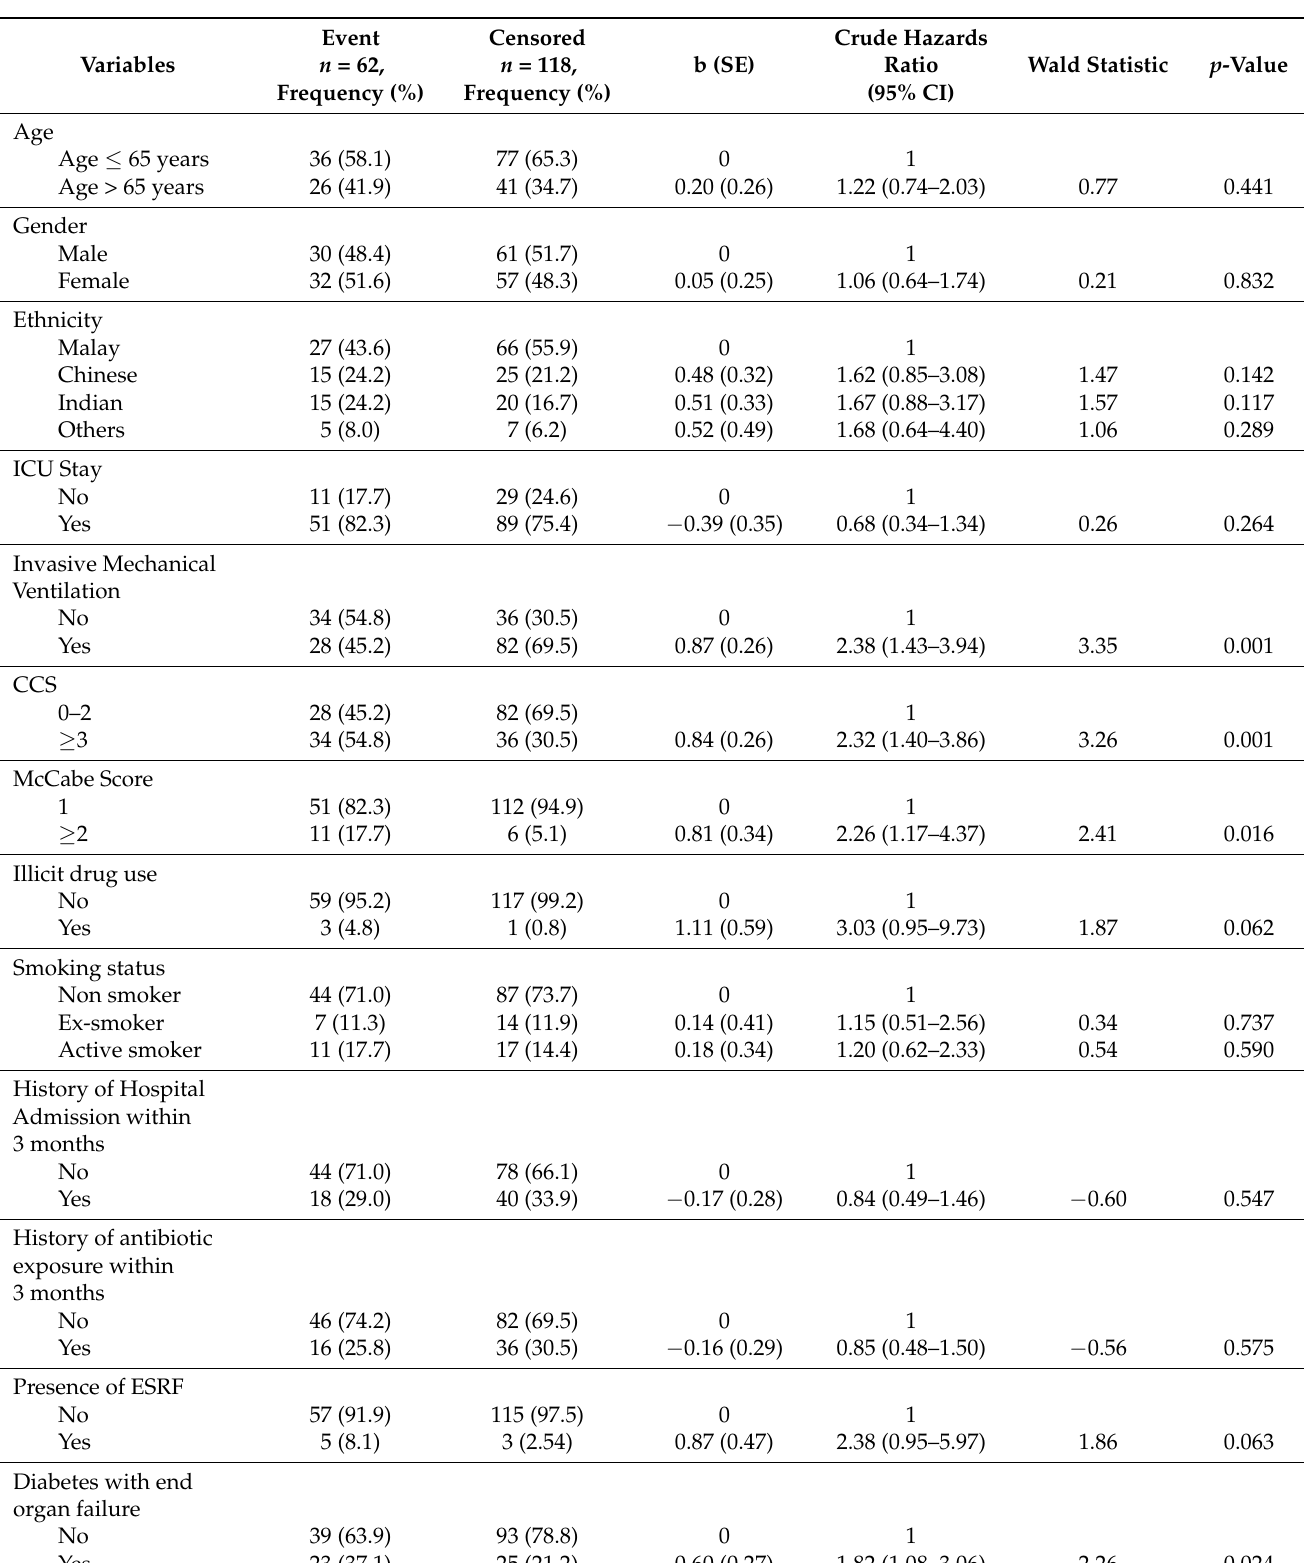
Table 4. Patient related factor of all-cause 30-days mortality in patients suspected with bacterial infection on extended or restricted antibiotic using simple Cox proportional hazards regression model ( n =